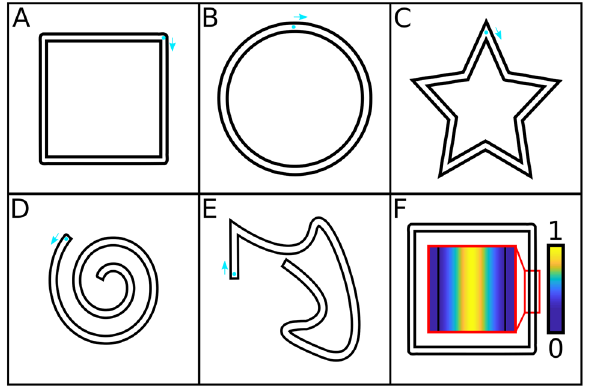
Figure 1. The shapes used for the shape drawing task ( a – e ). For every shape, the starting position is marked with a blue dot. Additionally, a blue arrow points from the starting position in the starting direction. Sub figure f shows an example of the scoring mechanism. An exemplary piece of the square shape (shown in a ) is magnified in the red box and the scoring weights are shown color-coded as described in the text. Yellow indicates a higher score, blue a lower